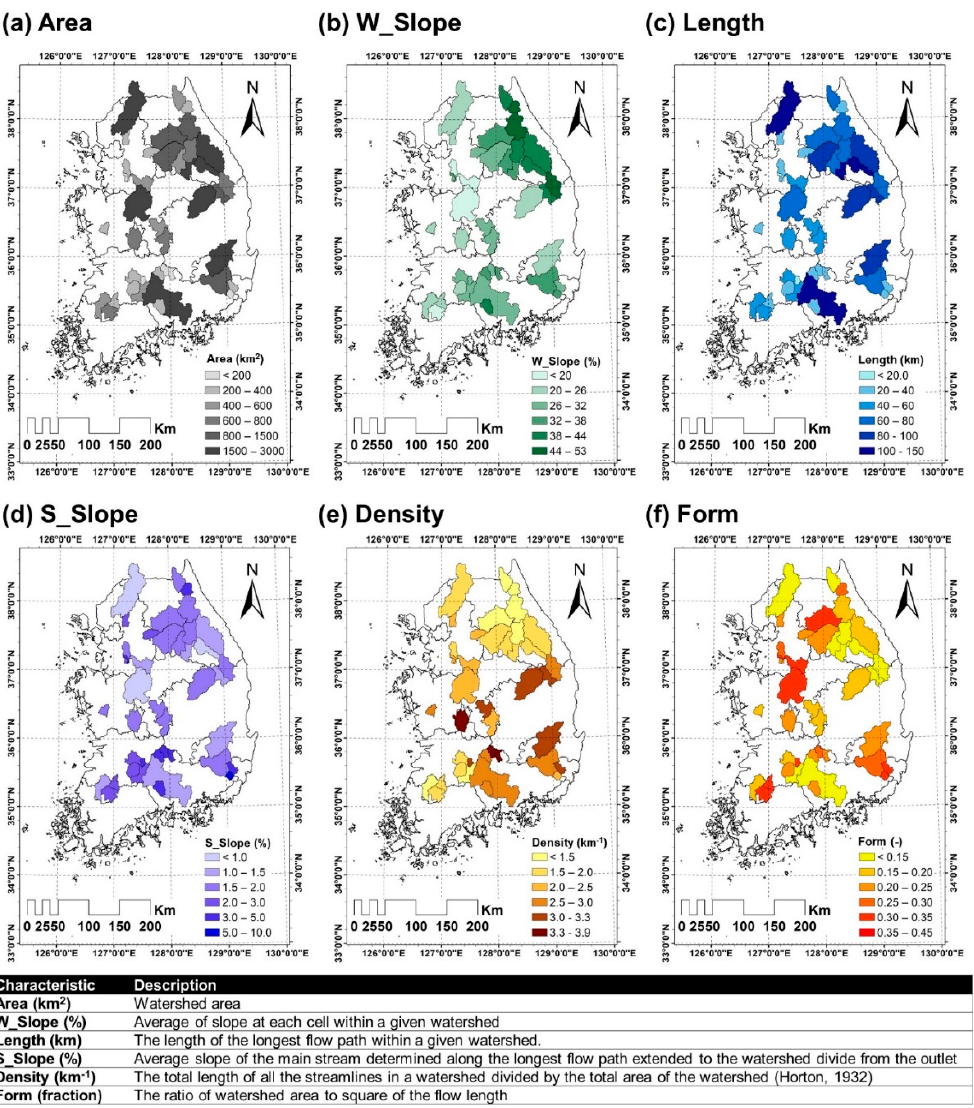
Figure 2. Spatial variations in the hydrologic characteristics of the 49 study watersheds.